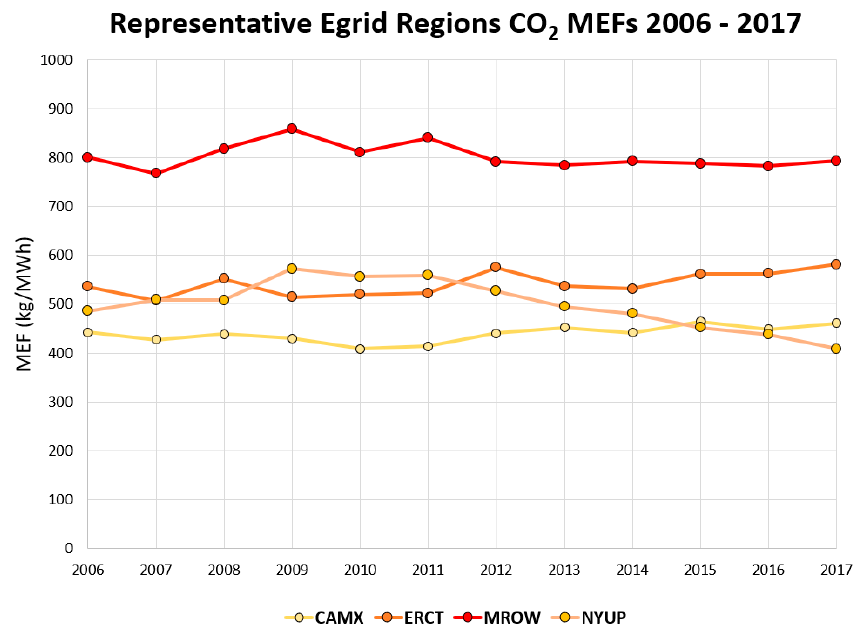
Figure 10. Change in CO 2 marginal emissions factor (MEF) from 2006 to 2017 for Upstate New York (NYUP), California (CAMX), Texas (ERCT), and the Upper Midwest (MROW). The MEFs have remained fairly constant in the eGRID subregions, with NYUP demonstrating the largest change over the 12 years analyzed.